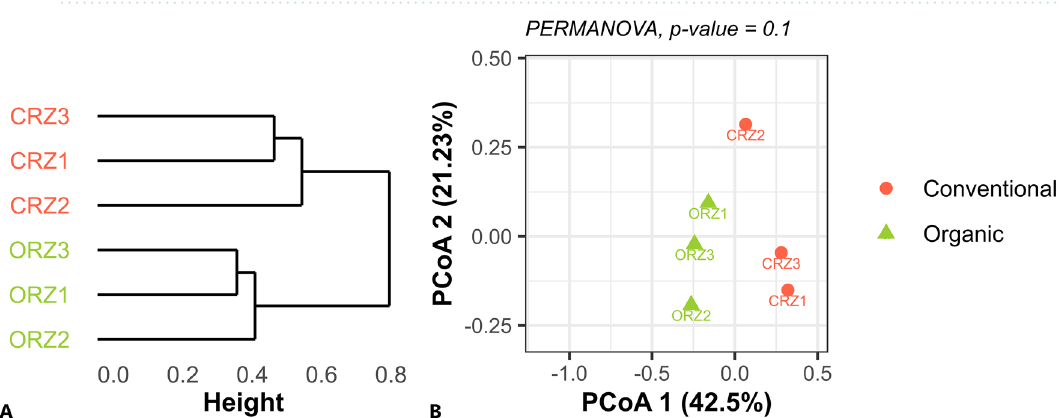
Figure 4. Dendrogram resulting from the hierarchical grouping of 16S rRNA samples from rhizospheric soil ( A ). Principal Coordinate Analysis (PCoA), based on the Bray–Curtis index of 16S rRNA samples from rhizospheric soil ( B ). Distance matrices were used for statistical comparison between the systems by a PERMANOVA analysis, considering a p -value ≤ 0.1.